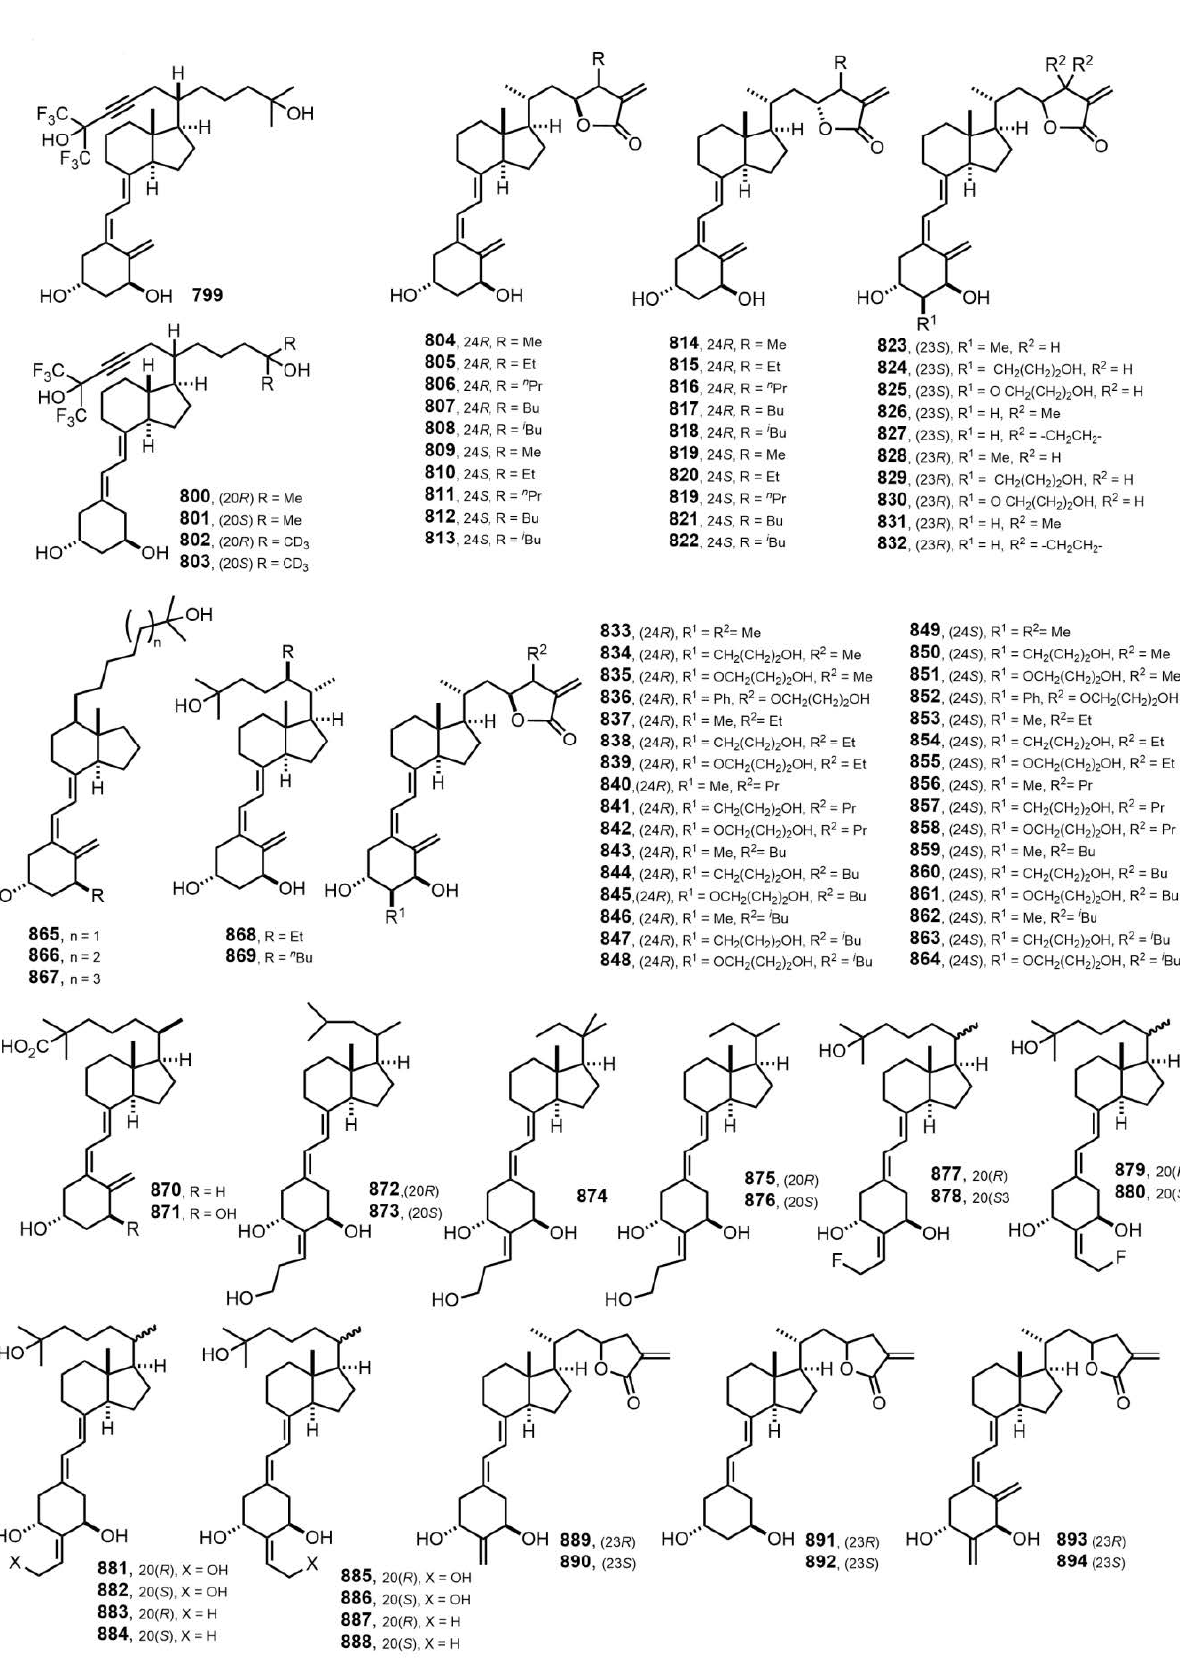
Figure 16. (2006–2008)